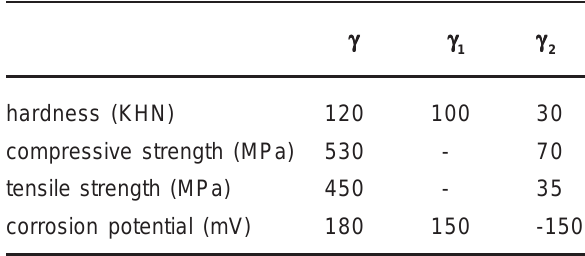
TABLE 1- Some characteristics of the different γ -phases in